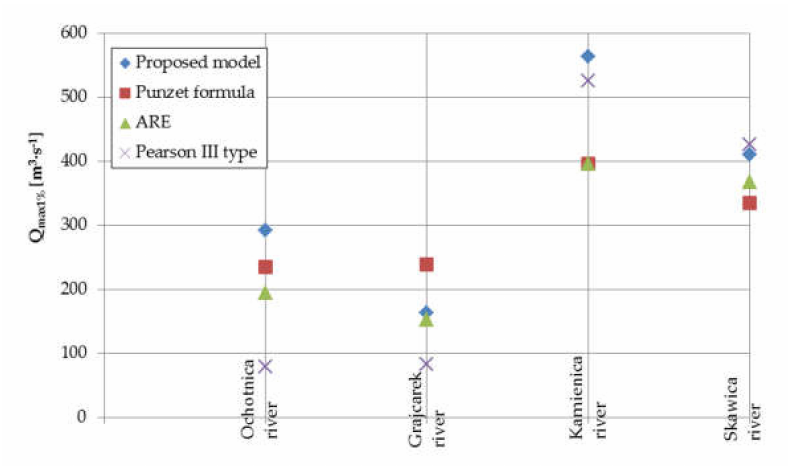
Figure 15. Comparison of Q max1% discharges achieved from proposed model, Punzet formula, and spatial regression equation (ARE) for four